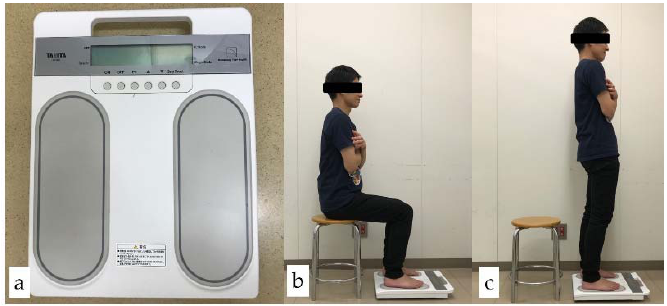
Figure 4. Motor function analyzer (zaRitz BM–220): ( a ) main unit; ( b ) measurement image (the beginning of analysis); ( c ) measurement image (motor function measurement after standing up).